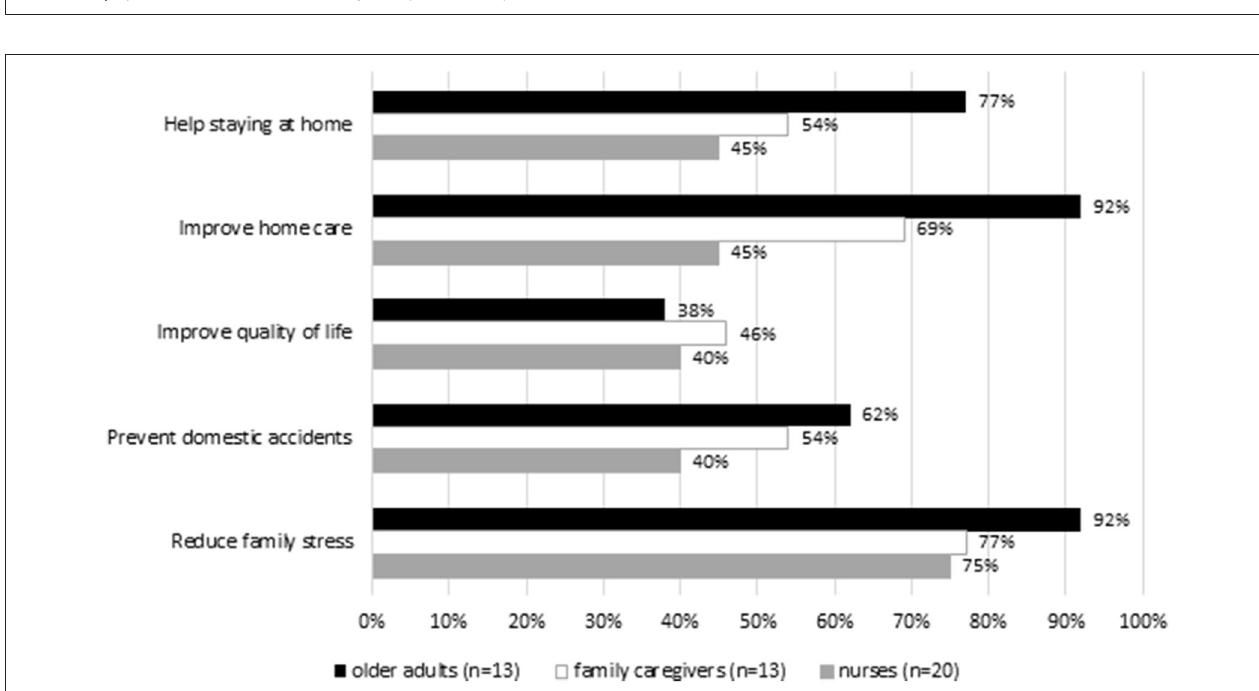
FIGURE 3 | Opinion on the wearable sensor (ECG).